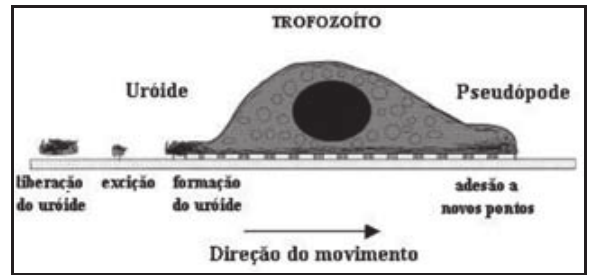
Figura 4 – Processo de formação e excisão da estrutura uróide na superfície da membrana plasmática de um trofozoíto